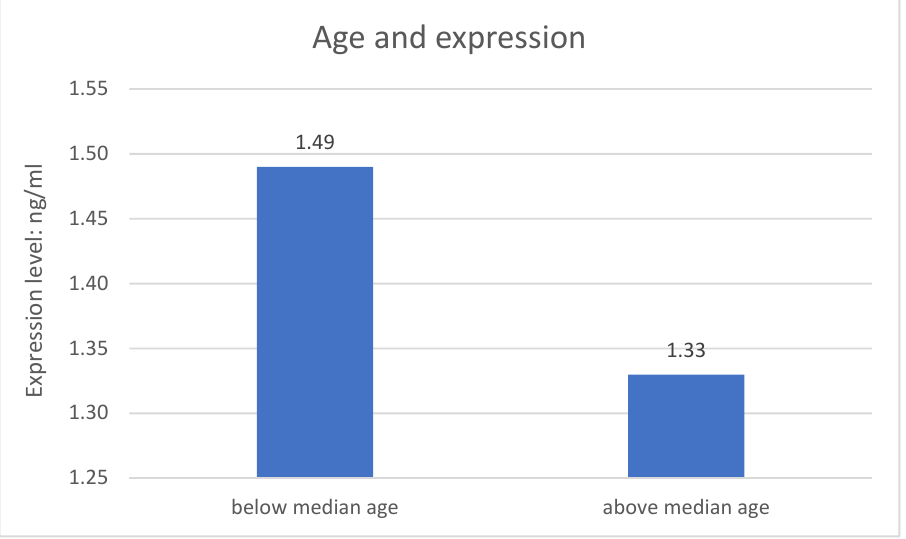
Figure 2. Age and expression of the studied gene.